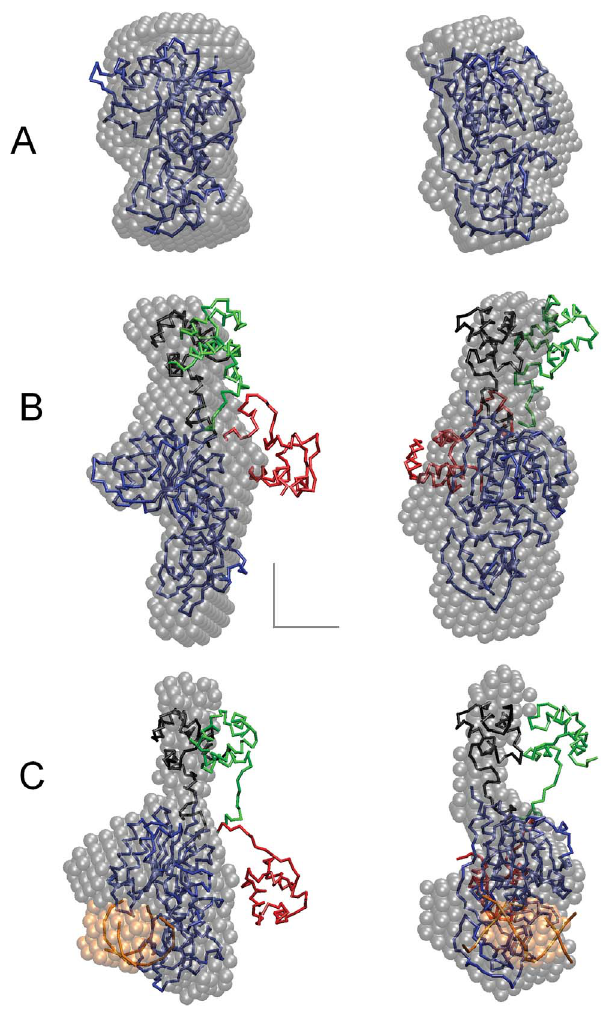
Figure 2. Structural models of M.NlaX, M.SsoII and its complex with DNA. ( A ) Ab initio bead model of M.NlaX obtained by DAMMIN (grey semitransparent spheres) superimposed with the crystallographic ‘‘M.HhaI model’’ (blue C a -traces). ( B and C ) Ab initio bead model of M.SsoII and M.SsoII–15met complex from DAMMIN/MONSA (gray semitransparent spheres correspond to M.SsoII, orange ones belong to the DNA) superimposed with the typical BUNCH model (black C a - traces) and with two typical conformations from an EOM ensemble (green and red C a -traces). The crystallographic ‘‘M.HhaI model’’ is displayed as blue C a -traces, the DNA molecule as orange helices. The right panels are rotated 90 u counter-clockwise around the vertical axis. Scale bar, 2